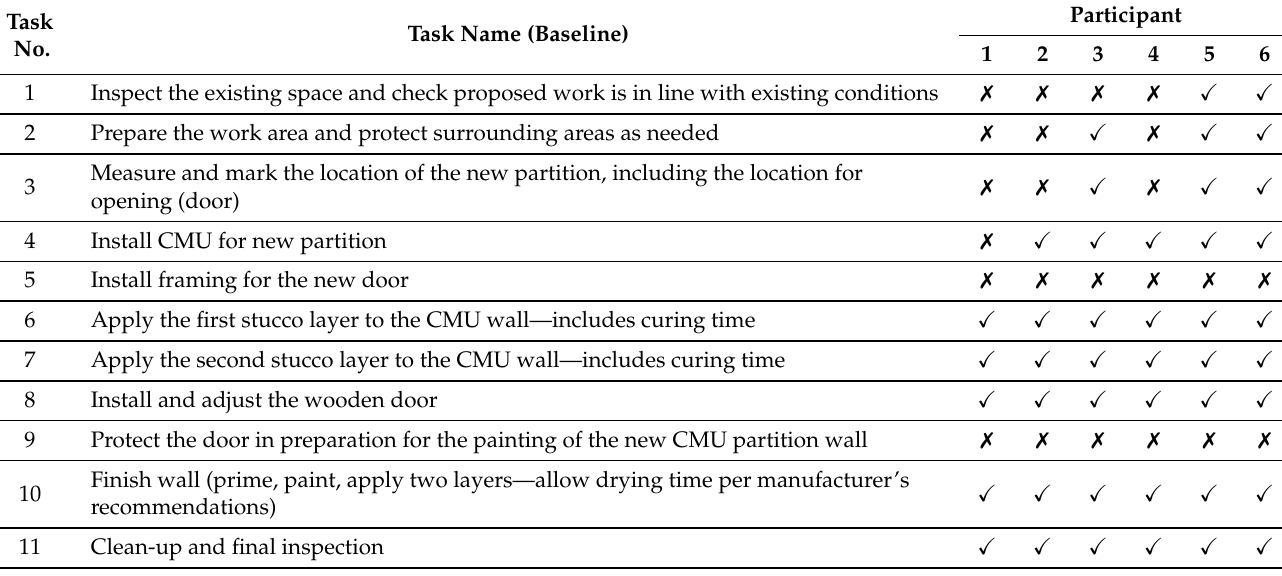
Table 3. Comparison of the tasks proposed in the schedules generated by ChatGPT with the ones from the baseline.